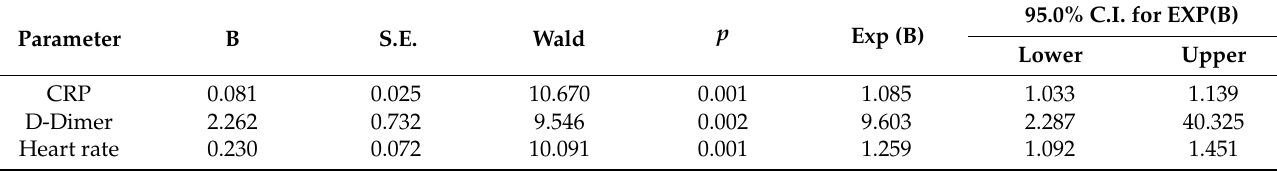
Table 5. Multivariable logistic regression analysis of mortality risk factors for patients with severe COVID-19